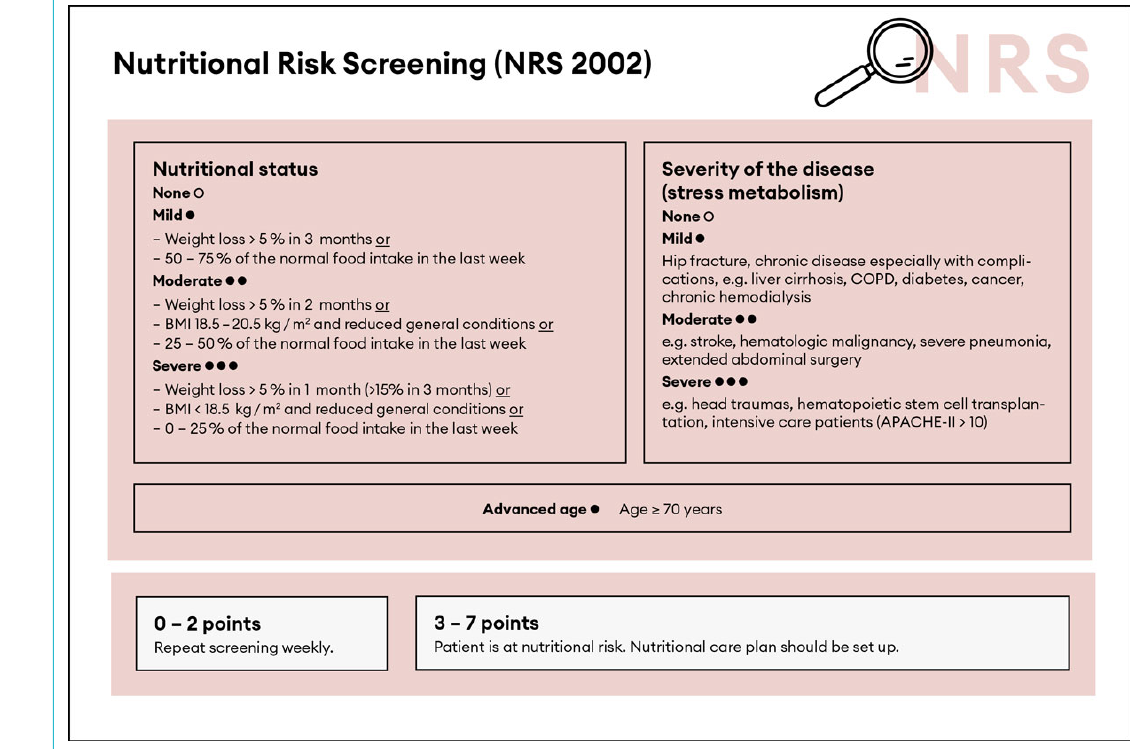
Figure 1: NRS 2002, adapted from Kondrup et al. [13] with permission from Elsevier.BMI = body mass index; COPD = chronic obstructive pul- monary disease; APACHE-II = APACHE-II